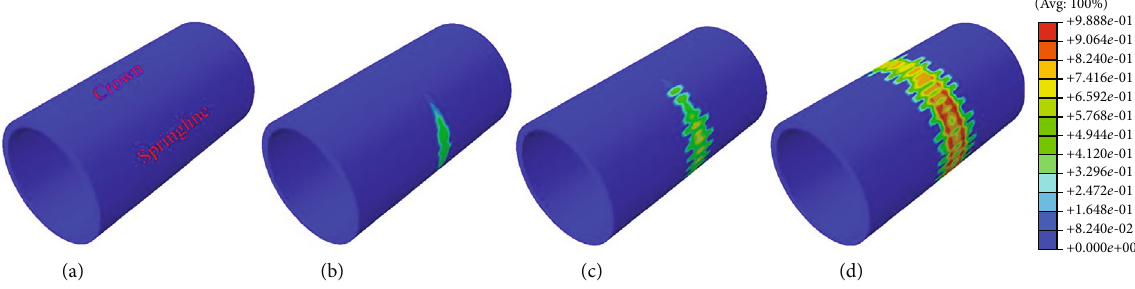
Figure 13: Concrete damage under combined loads: (a) P-r-5; (b) P-r-10; (c) P-r-15; (d)